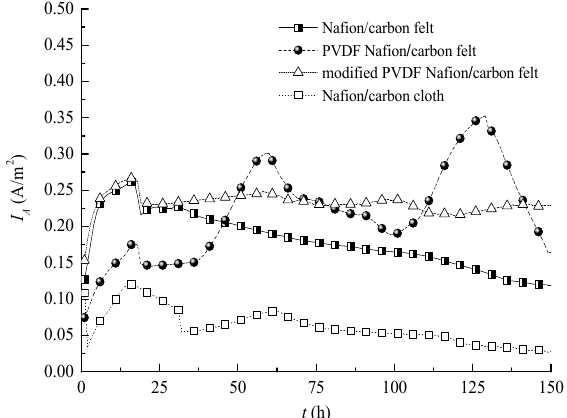
Figure 4. Current density curves of MFCs in different conditions. Table 1. Steady-state values and their standard deviations of current density.